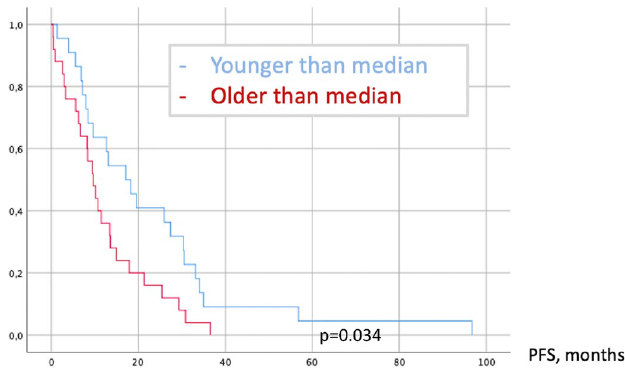
Figure 1. Achieved PFS in relation to age.